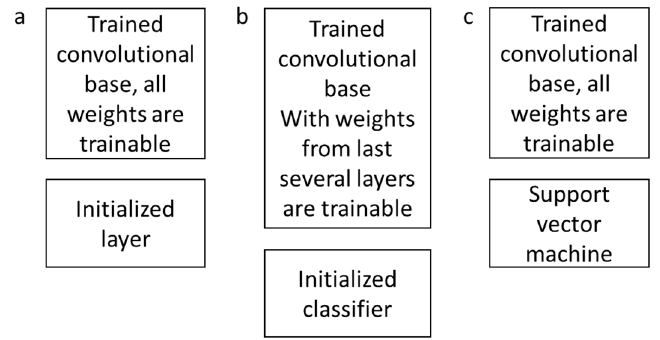
Figure 4. Three different transfer learning scenarios—( a ) fine-tuning the whole network; ( b ) fine-tuning higher layers of the network and ( c ) convolutional base as feature extractor.